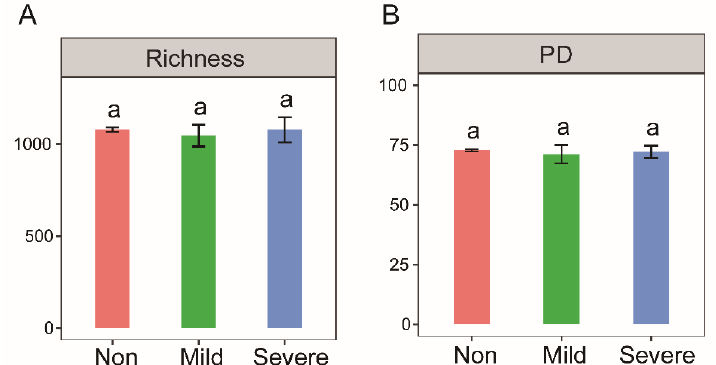
Figure 2. Bacterial diversity indices of the soils with three salinity levels: Non–salinity, Mild–salinity and Severe–salinity. The diversity index Richness denotes the bacterial variations at the taxonomic level ( A ), and PD (phylogenetic diversity) denotes variations at the phylogenetic level ( B ), in other words, evolutionary relationship. The same letters above bars denote no significant difference ( p > 0.05) among salinity levels.